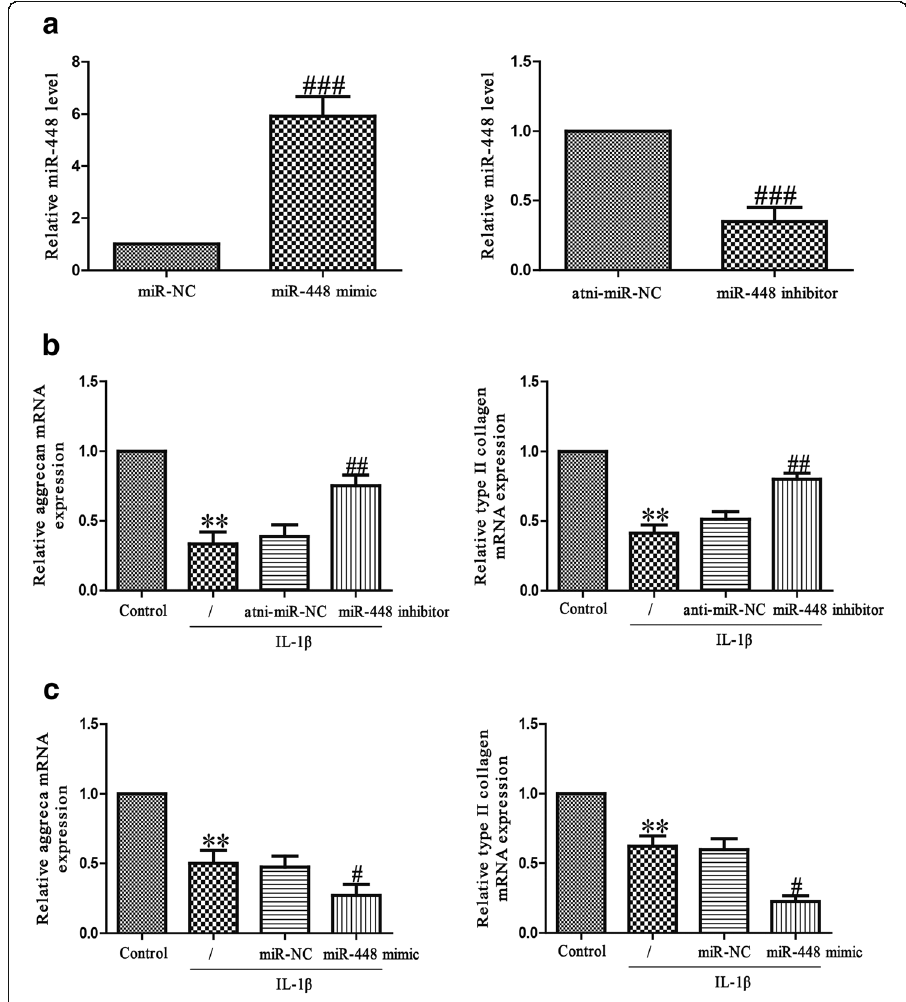
Fig. 2 Effects of miR-448 on IL-1 β -induced inhibition of aggrecan and type II collagen mRNA expressions inchondrocytes. a Chondrocytes were transfected with miR-448 mimic or inhibitor. The level of miR-448 was determined using quantitative real-time PCR. Chondrocytes were treated with 5 ng/ml IL-1 β for 24 h after transfection with miR-448 inhibitor b or mimic c . The mRNA levels of aggrecan and type II collagen were determined using quantitative real-time PCR. The data shown are means ± SEM, n = 4. ** p < 0.01 vs. control; # p < 0.05, ## p < 0.01, ### p < 0.001 vs. vehicle + IL-1